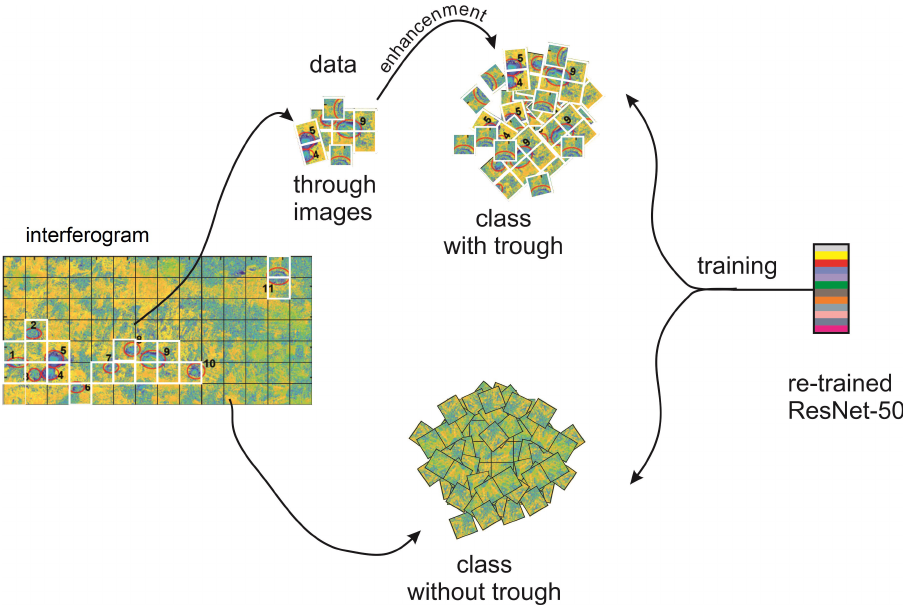
Figure 1. Training stage used in the presented